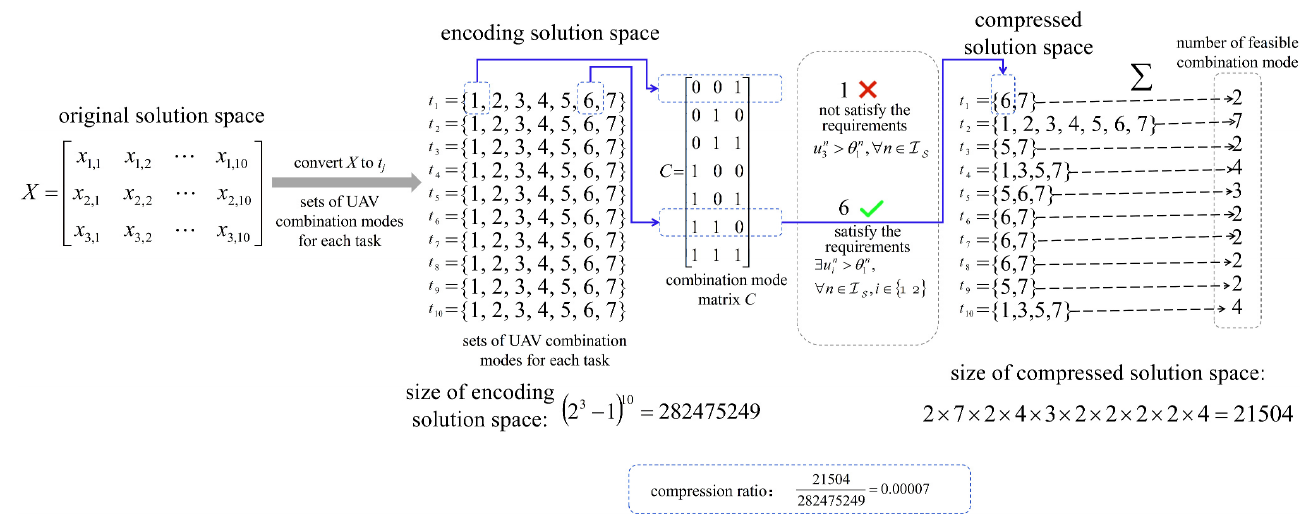
Figure 4. Example of solution space compression process of three UAVs and ten